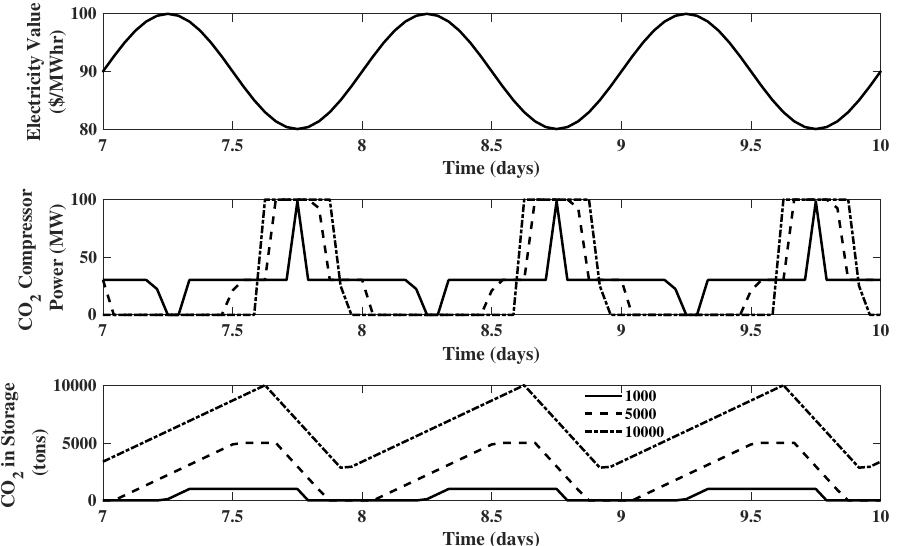
Figure 9. Closed-loop simulation of EMPC using a 24 h prediction horizon for Example